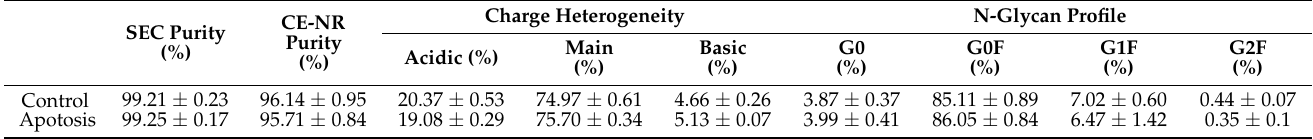
Figure 8. Process performances after glucose supplementation. ( a ) Change in the cell viability with culture time. ( b ) Effect of different glucose withdrawal times on the specific productivity of the protein expression. Data are expressed as mean ± standard error of three replicates. ** p < 0.01. Table 2. Effect of apoptosis on the quality of antibody.